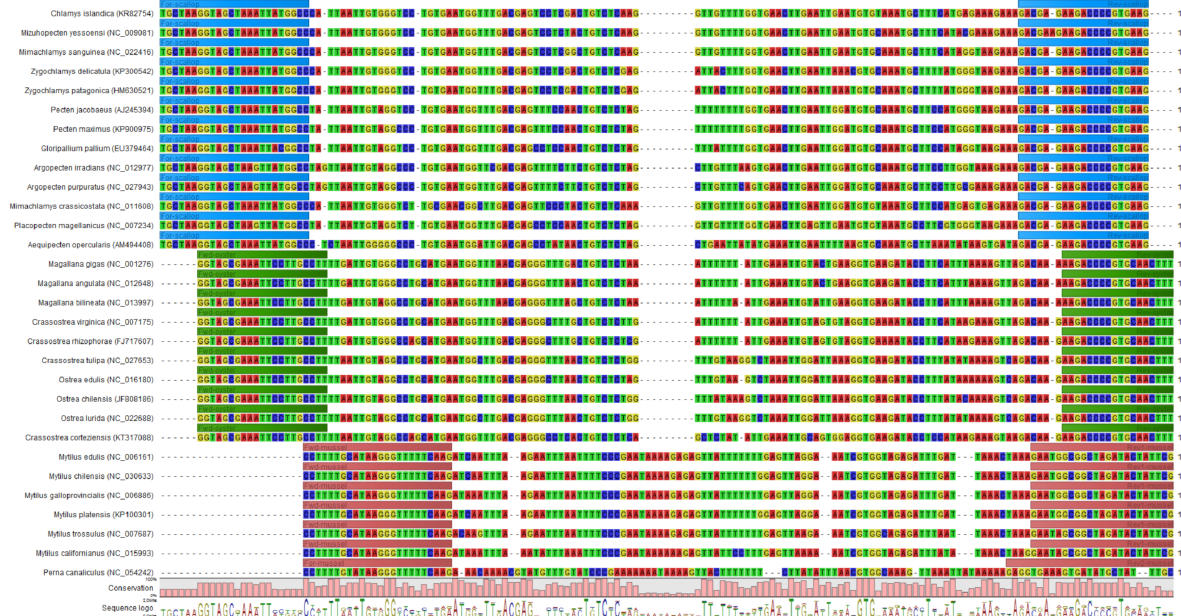
Figure 1. Multi-species sequence alignment of the mitochondrial 16S rDNA barcoding region for bivalve species. Colored bars indicate the binding sites of the primer sets for scallops (blue), oysters (green), and mussels (red, CLC Genomics Workbench software version 10.1.1, Qiagen, Hilden,